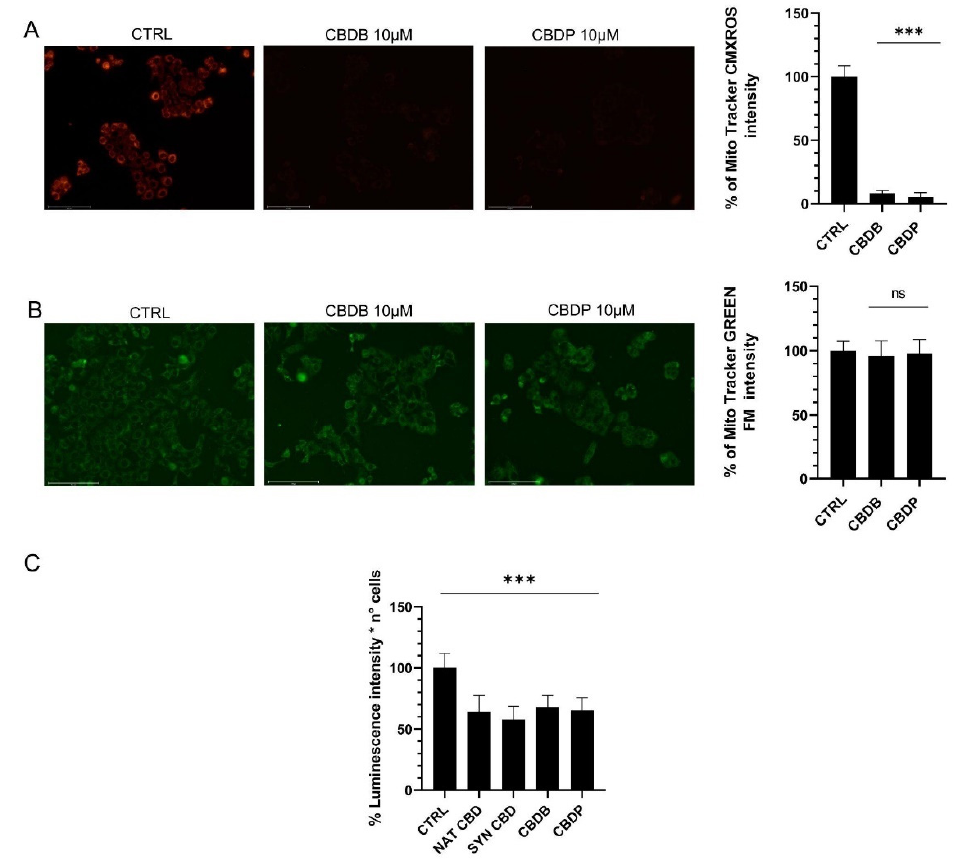
Figure 4. Representative fluorescent images of the mitochondrial function. MCF-7 cells were treated with vehicle (DMSO), CBDB and CBDP (10 µM) for 24 h. ( A ) Cells were stained with the membrane potential-dependent dye MitoTracker CMXRos. ( B ) Cells were stained with the MitoTracker Green FM. Both fluorescent markers were imaged with an Evos m7000 fluorescence microscope. Scale bar 150 µm), objective 20x. ( C ) After treatments, the cellular ATP level was measured with the CellTiter-Glo 2.0 cell viability luminescence assay. Values are the mean ± SD. *** p < 0.001 compared to controls; ns not significant.